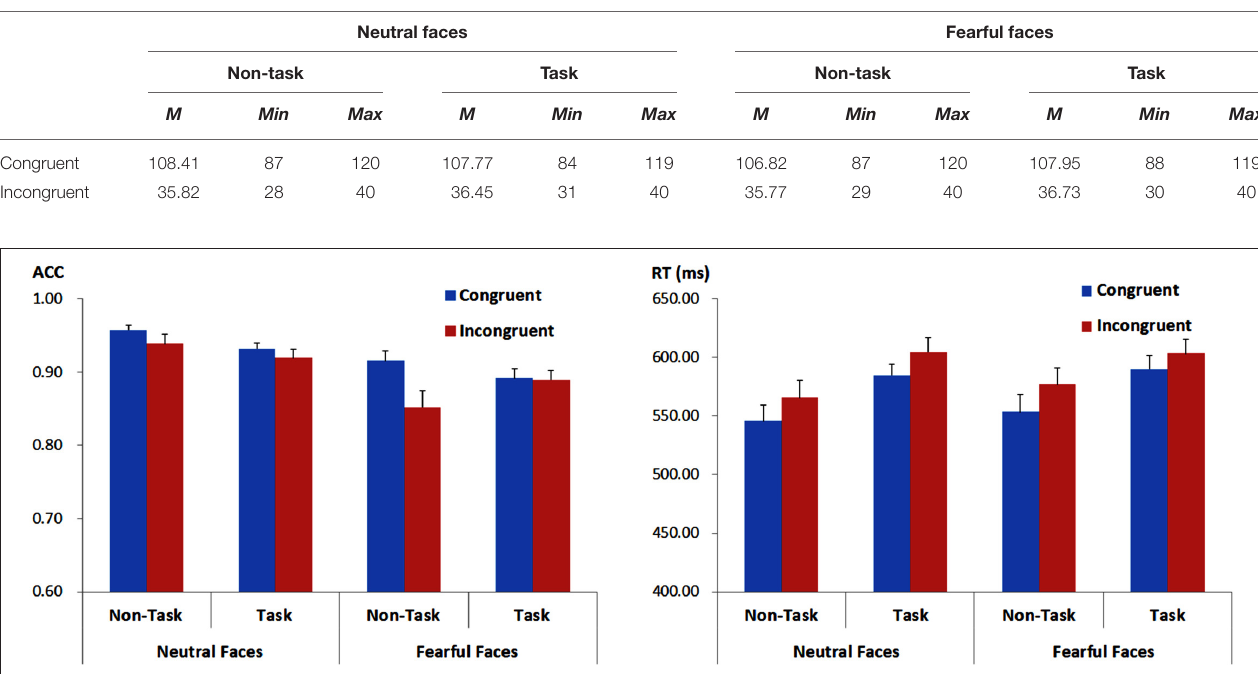
FIGURE 2 | ACC (the left panel) and RTs (the right panel) for recognition of facial expressions for each experimental condition. Vertical lines indicate the standard error of the mean.